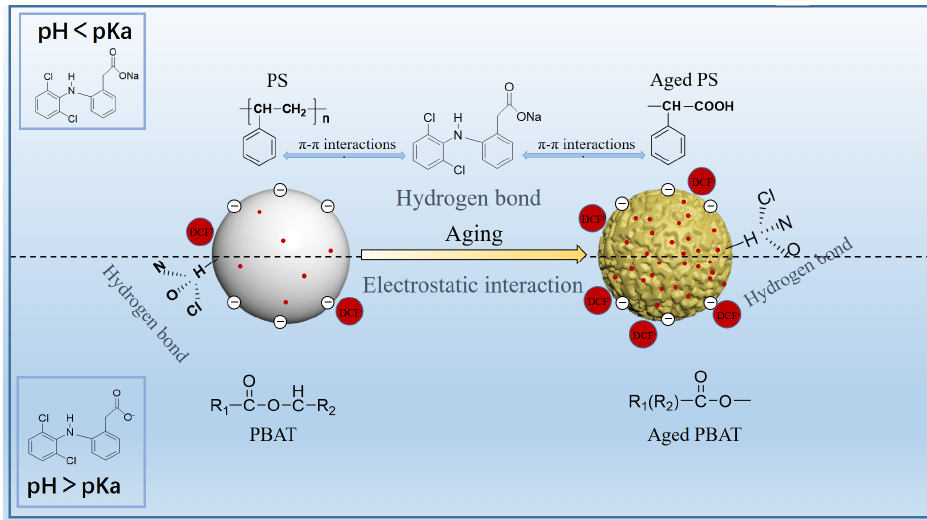
Figure 9. Mechanism of DCF adsorption by